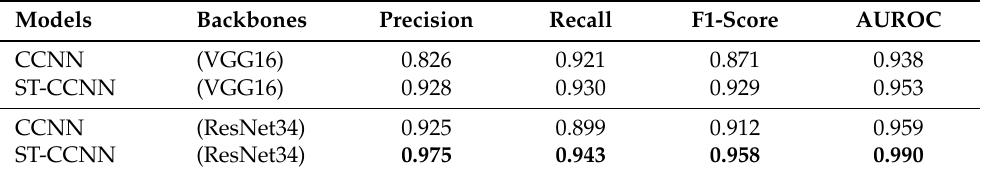
Table 6. Ablation study of with/without ST on single modality datasets